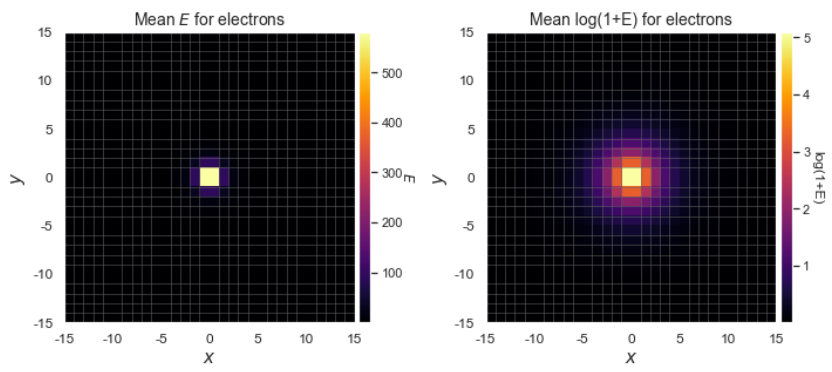
Figure 1: Visualisation of the